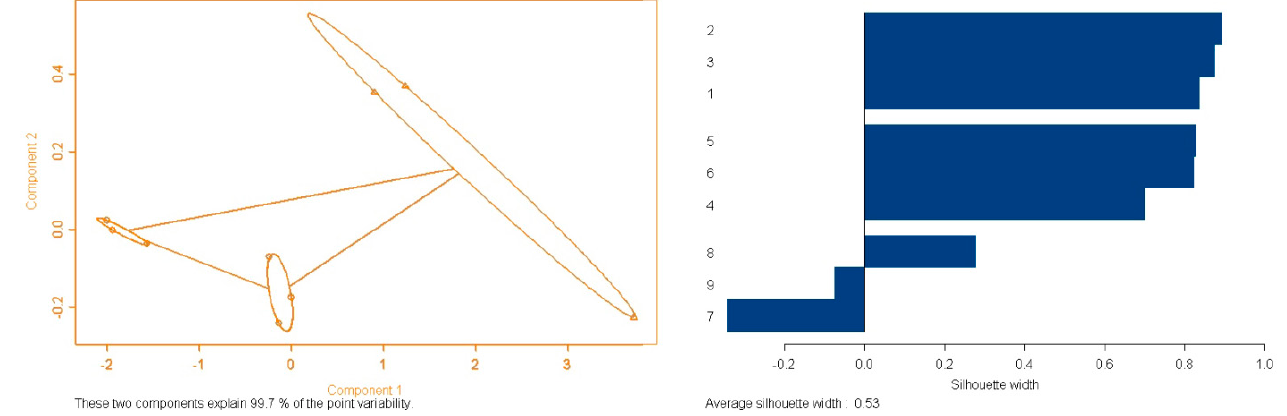
Figure 1. Classification of methyl, ethyl and isopropyl alcohols by sensor array based on QCM sensors with H 2 Pc, CuPc, and PbPc coatings. The classification failed as there are negative values of silhouette width.